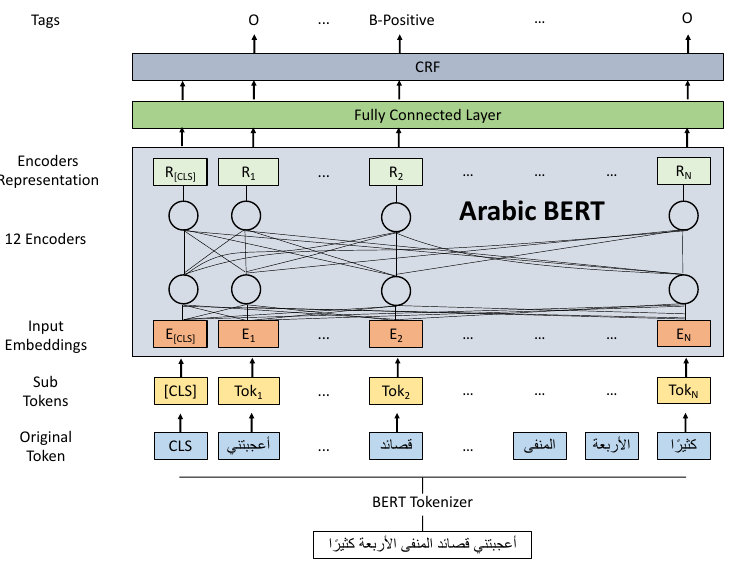
Figure 1. Architecture of Arabic BERT+CRF models [27]. An Arabic BERT-CRF model is fed text. To contextualise the word and create the final representation, tokens are